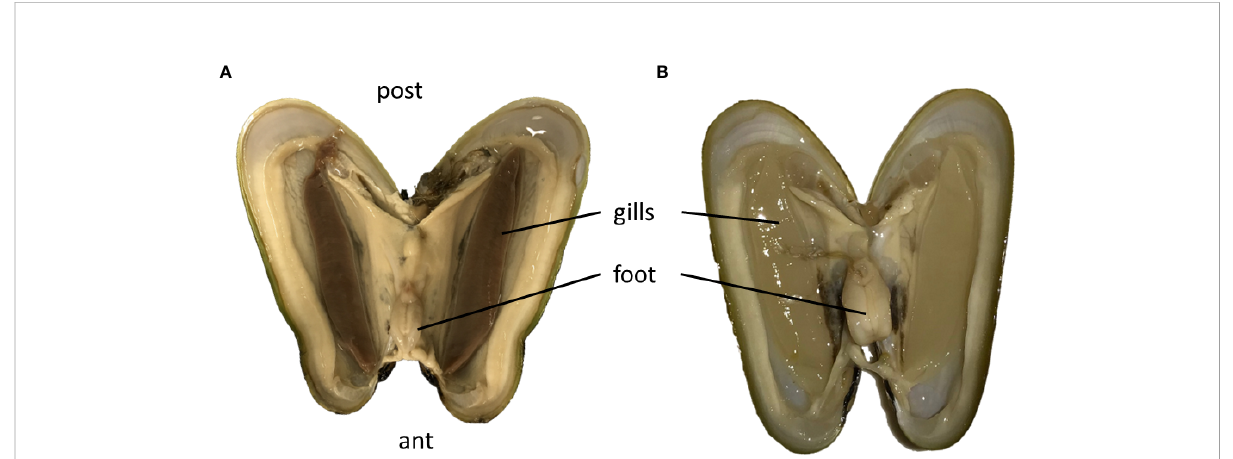
FIGURE 1 Open mussels of B azoricus with their pairs of thick brown gills just upon collection (A) , which become translucent and thin after 61 days of starvation (B) . Ant, anterior part of the mussel shell; post, posterior part of the mussel shell; The shells measured about 4 cm in length. (A) is modi fi ed from Piquet et al., 2019 in Plos One with